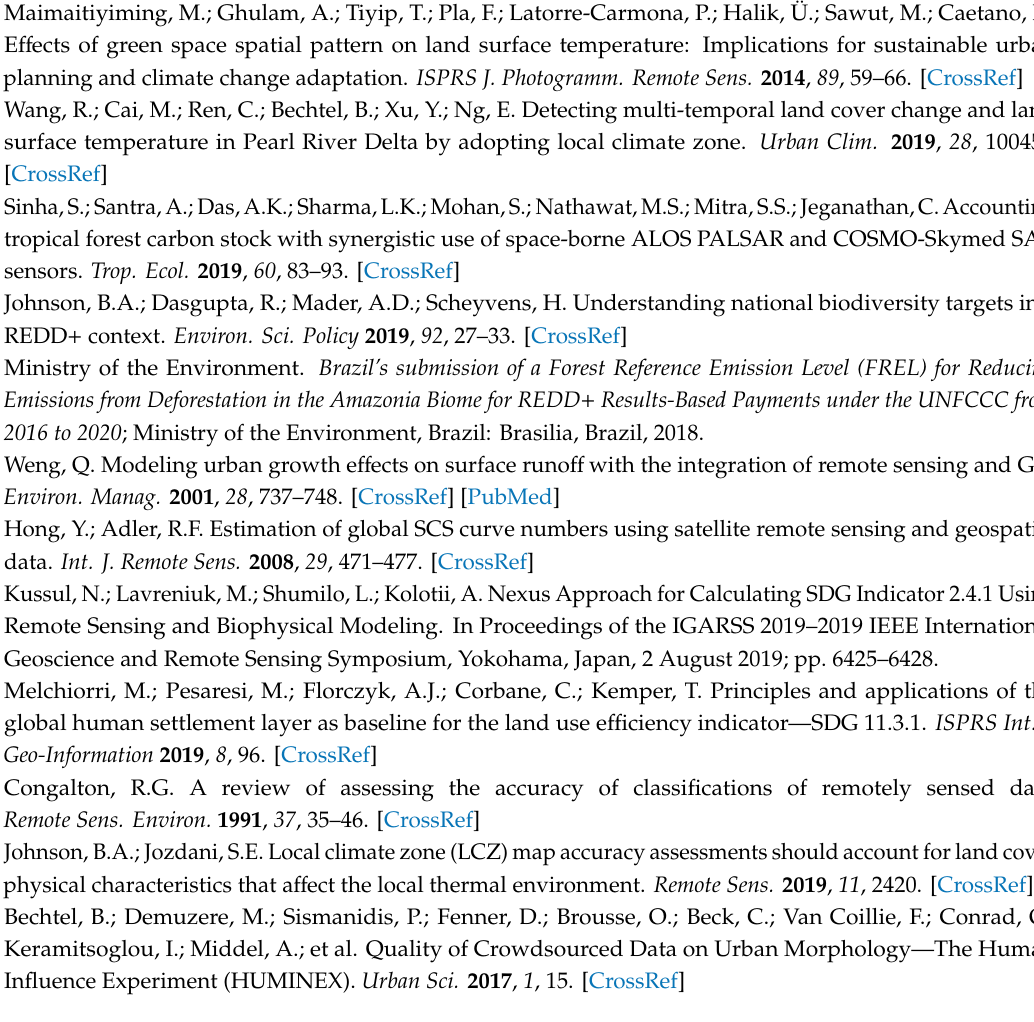
Table S1: Parameter values, Table S2: Dij values, Table S3: JJ20 metric